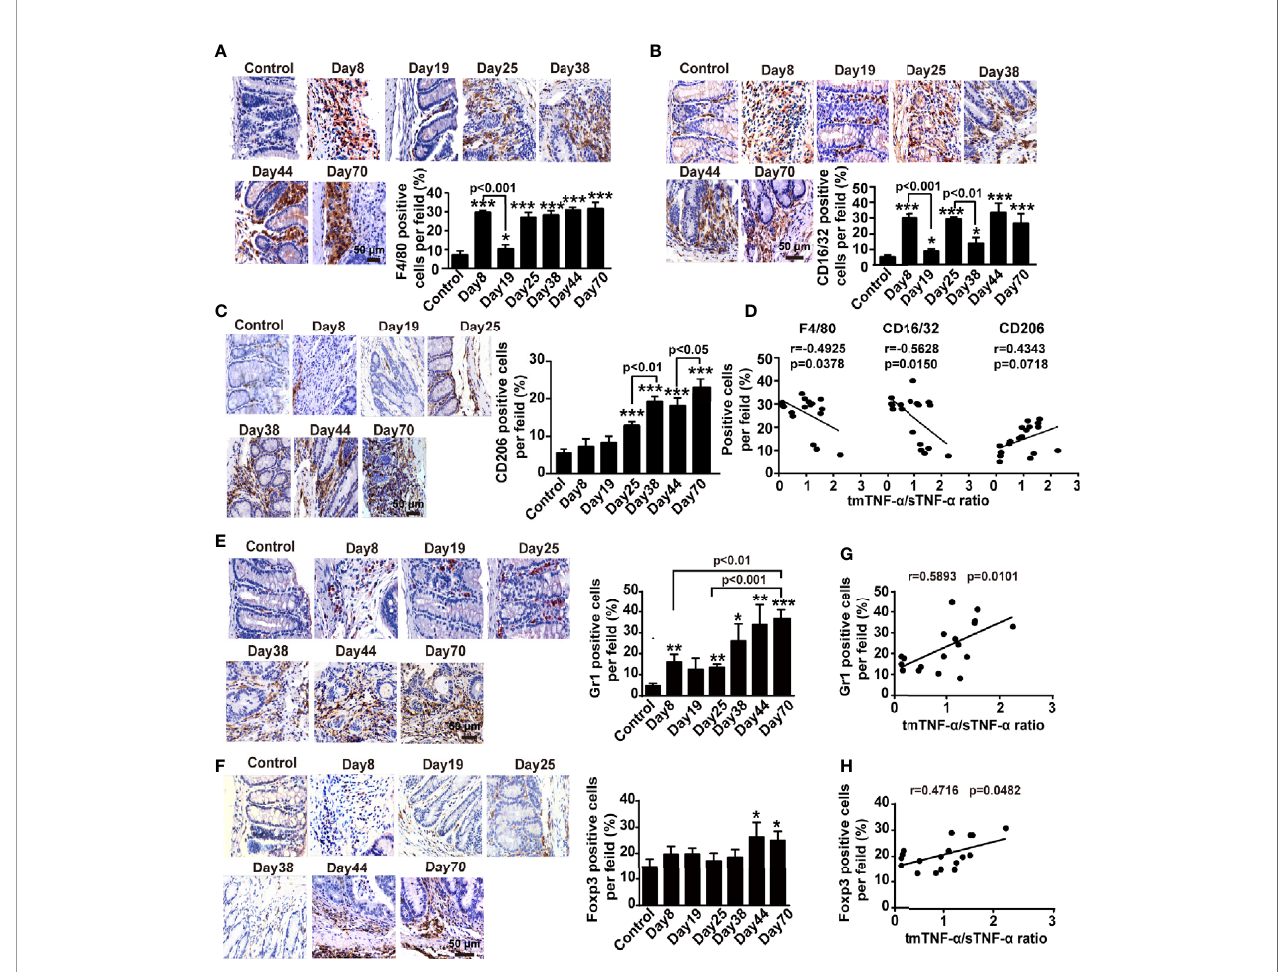
FIGURE 3 | The tmTNF- a /sTNF- a ratio negatively correlates with the accumulation of macrophages but positively associates with the in fi ltration of MDSCs and Treg cells in the colonic tissue of CAC. Mice were treated with AOM and DSS as described in Figure 1A (n = 6-8, each group). Representative immunohistochemistry images of F4/80 + macrophages (A), CD16/32 + M1 type (B) or CD206 + M2 type macrophages (C), Gr1 + MDSCs (E) and Foxp3 + Treg cells (F) in fi ltrated in colonic tissues (×400) and their quantitative data. The correlation of the tmTNF- a /sTNF- a ratio with percentages of F4/80 + macrophages, CD16/32 + M1 type or CD206 + M2 type macrophages (D) , MDSCs (G) and Treg cells (H) (n = 18). All quantitative data are expressed as means ± SEM. *P < 0.05, **P < 0.01, ***P < 0.001 versus